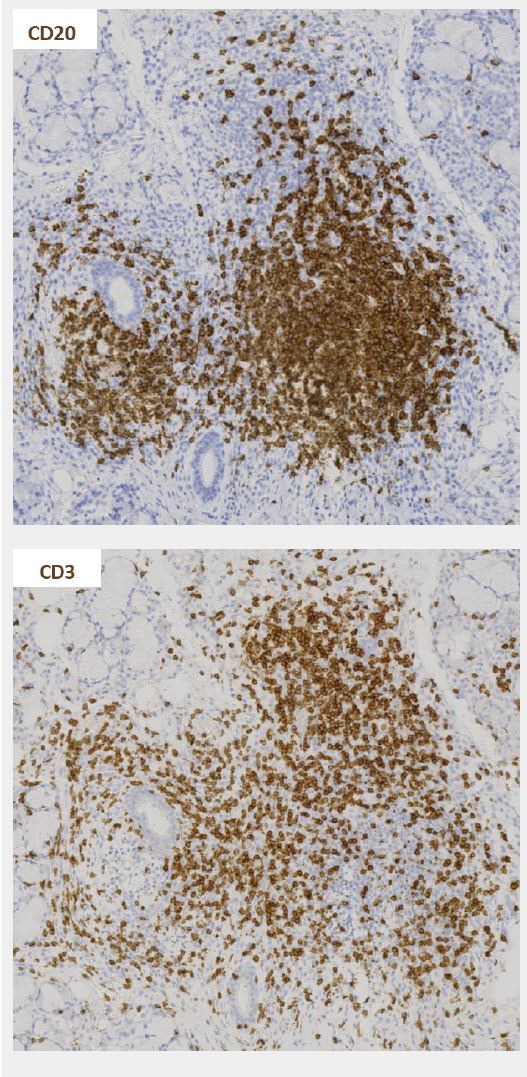
Haematoxylin and eosin staining of labial salivary gland biopsy with evident lymphoepithelial lesion.